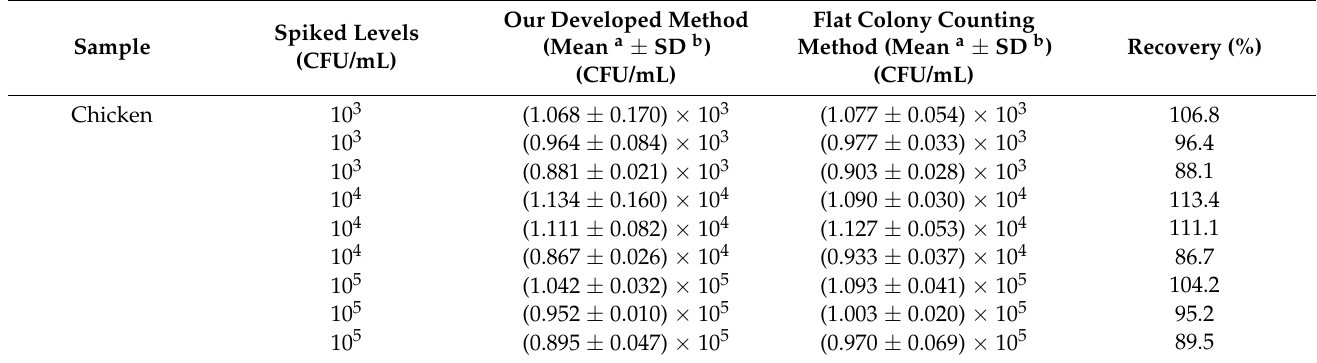
Table 2. Determination of Shigella in real chicken samples using the developed upconversion fluorescence